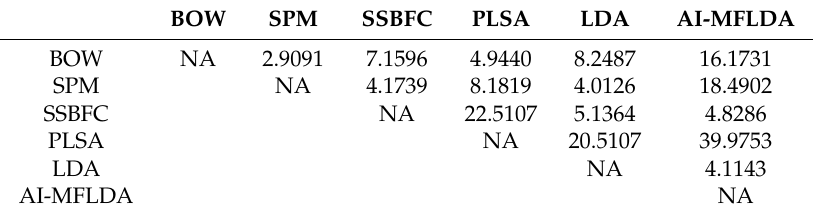
Table 2. McNemar’s test values of the different classification